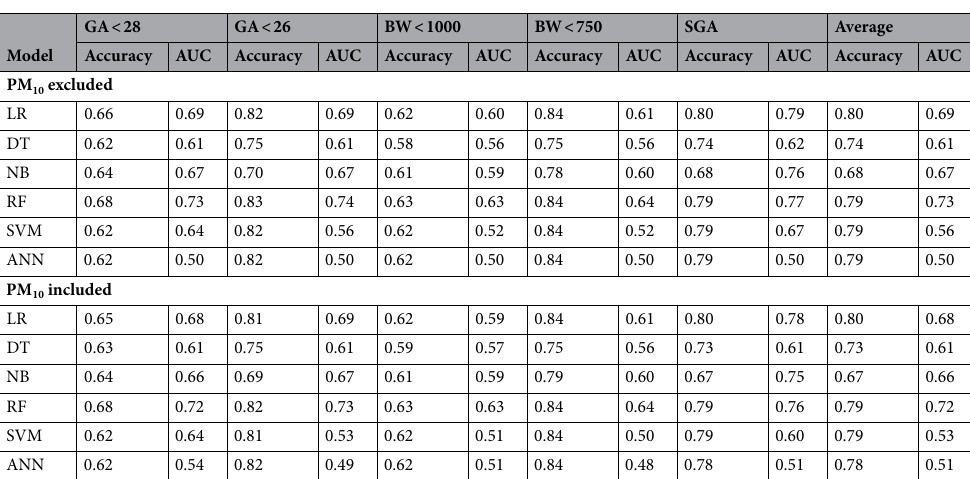
Table 3. Model Performance. ANN artificial neural network; AUC, area under the receiver-operating- characteristic curve; BW, birth weight (grams); DT, decision tree; GA, gestational age (weeks); LR,